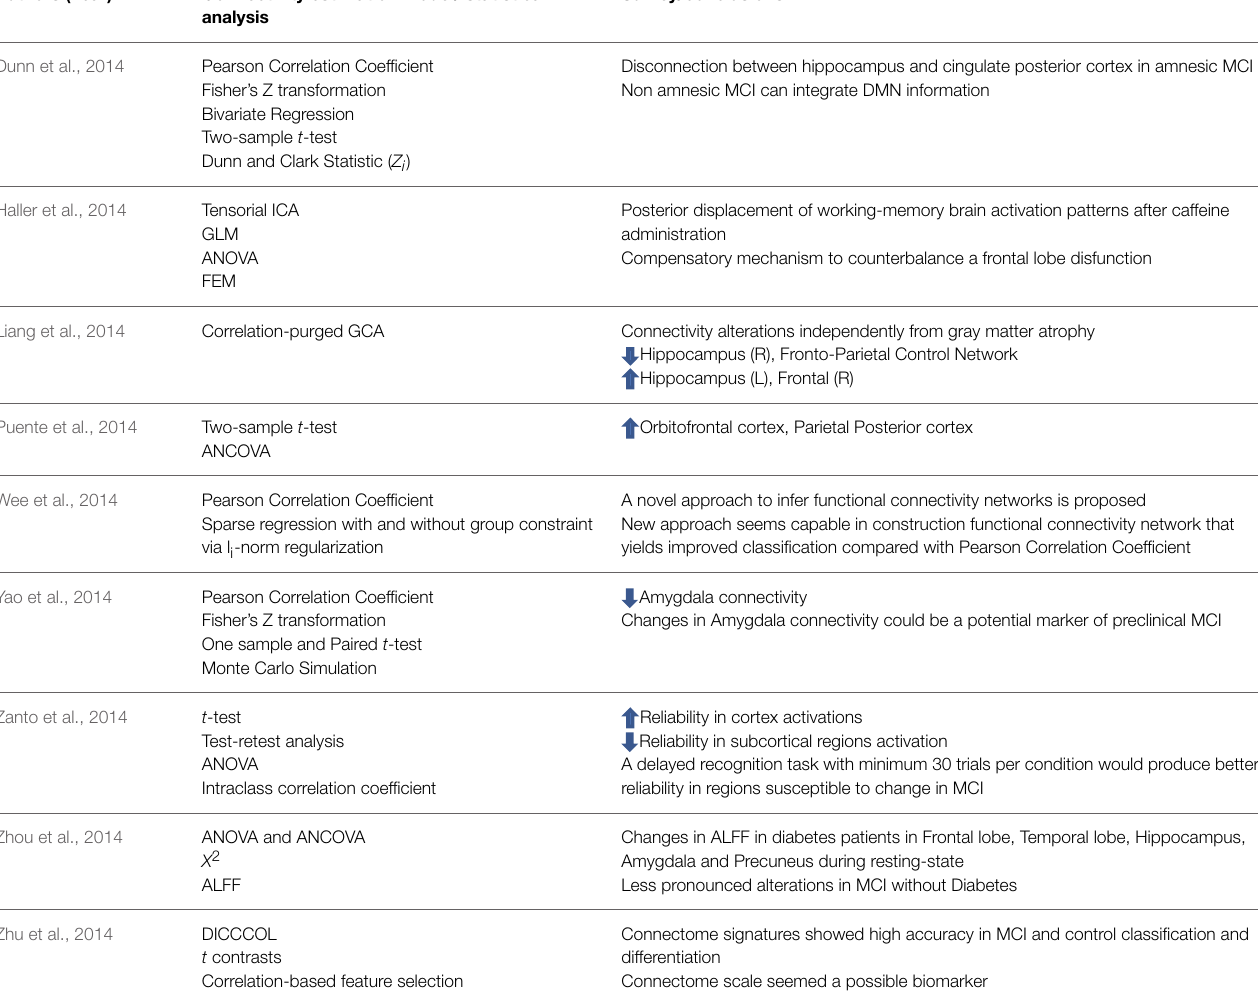
Connectome signatures showed high accuracy in MCI and control classification and